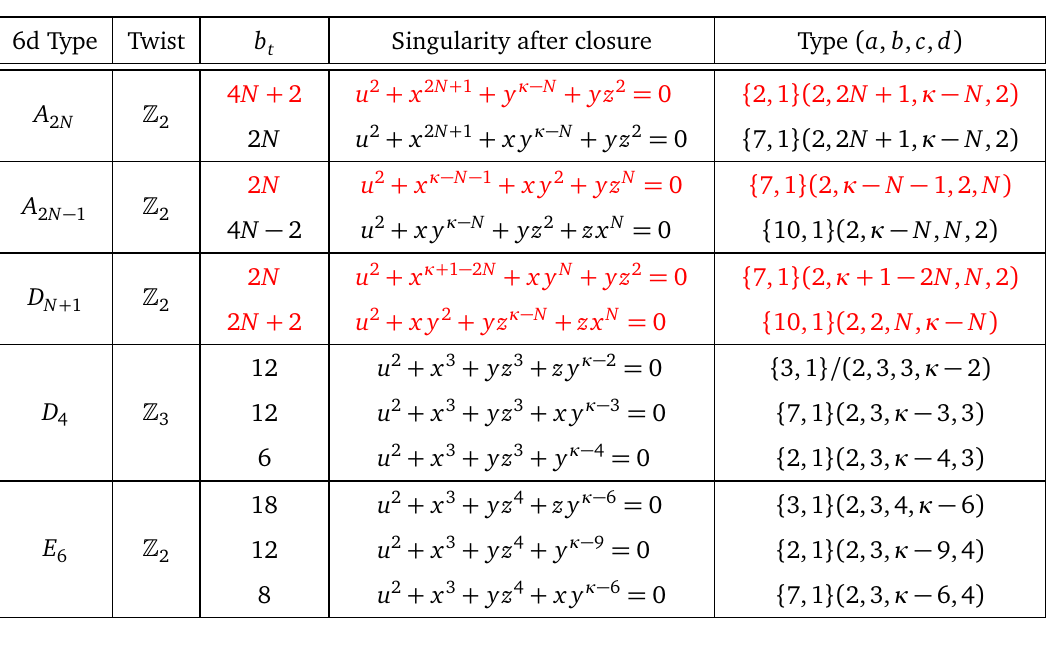
Table 3: Twisted irregular punctures of IHS type: In the fourth column the relevant hypersurface singularity in (cid:67) 4 is provided and in the last column we report the cor- responding singularity type according to the KS-YY classification (see [ 55 ] for our conventions). Entries in red are those already identified in [ 106 ] . In the first column we provide the corresponding 6d N = ( 2,0 ) theory and in the second column we indicate the outer-automorphism twist